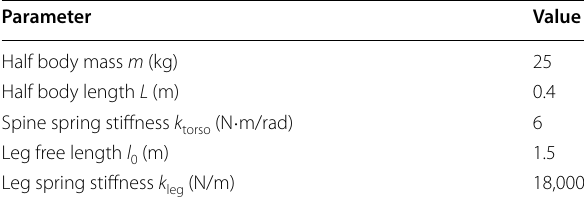
Table 1 Parameters of the spine-joint model Parameter Value Half body mass m (kg) 25